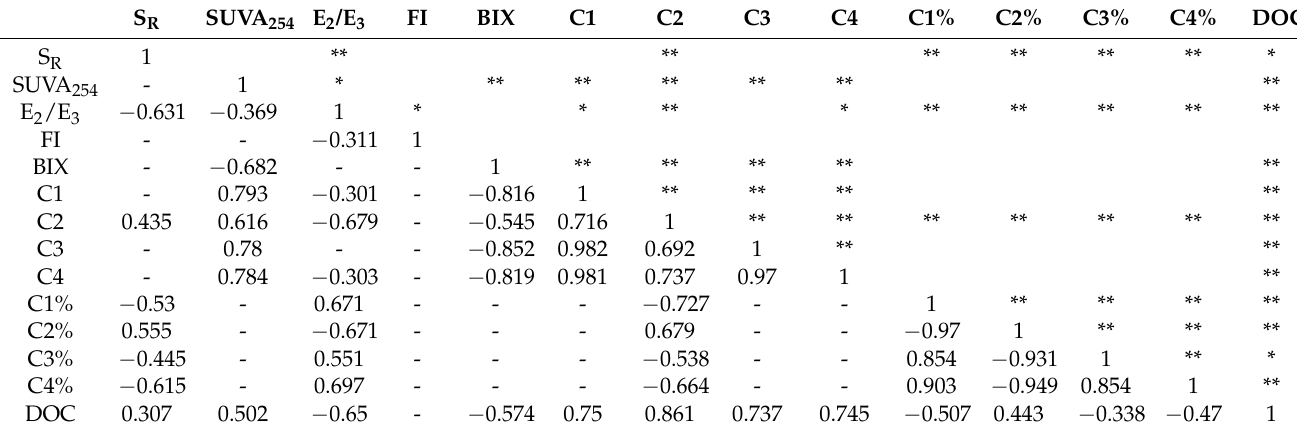
Figure 5. NMDS analysis of all spectral indicators for 44 water samples from three sampling sites. The ordination is generated based on Bray–Curtis distance (k = 2, stress = 0.048). The Squre, circle and star symbols separately represent SW, OW and PW samples. The colours red, blue and orange represent the sampling sites of OR, NB and NS, respectively. The Black arrow lines represent the spectral indicators, such as E 2 /E 3 , S R , FI, BIX. Table 4. Spearman correlations among DOC concentration, spectral indicators, and FDOM